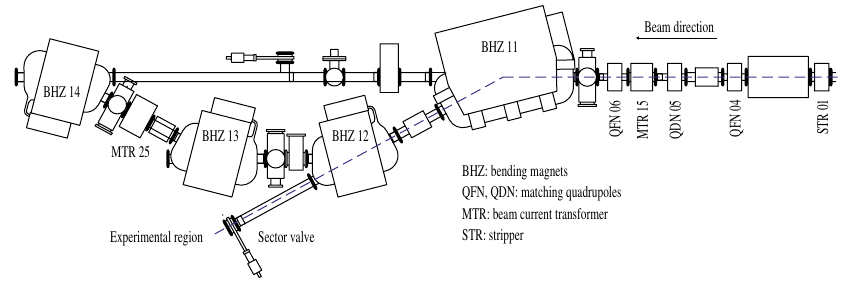
FIG. 1. (Color) Layout of magnetic elements in the LINAC 3 filter line used to steer the ion beam into the experimental setup which is separated by a sector valve from the